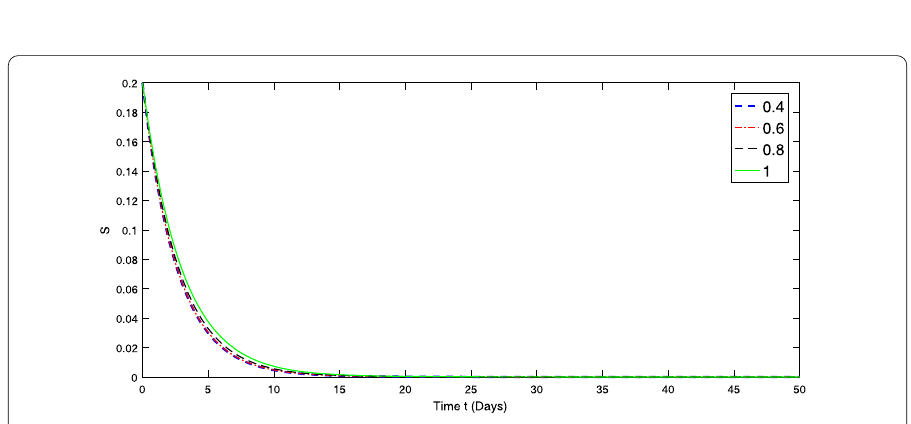
Figure 2 Graphical representation of numerical solution for specie S at various fractional orders of the considered model (4)